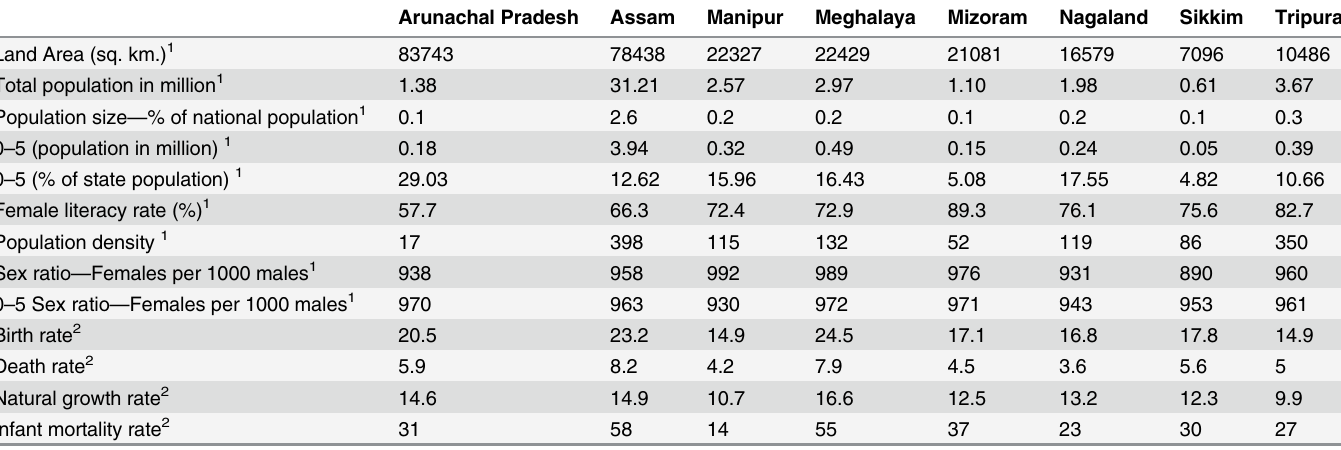
Table 1. Profiles and demographic characteristics of states in northeast